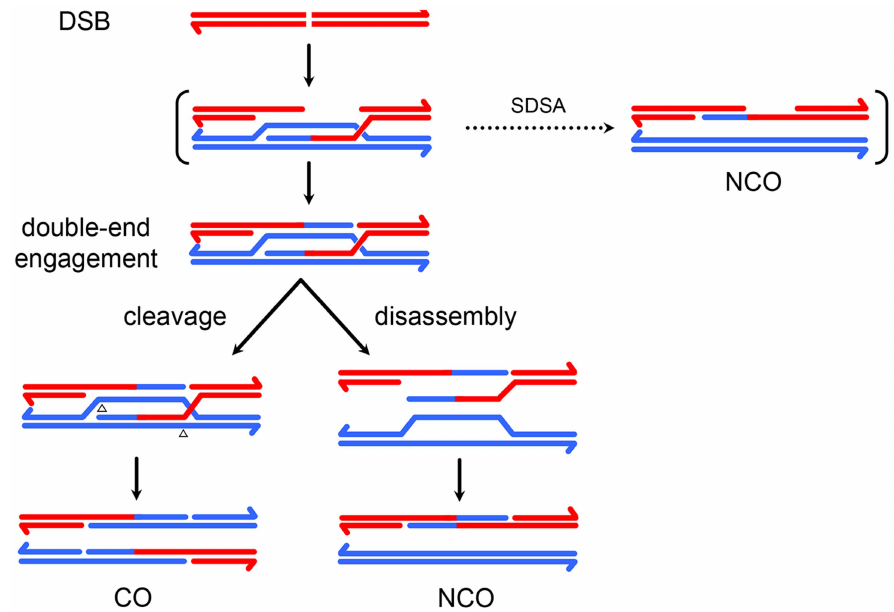
Figure 6. A model for meiotic recombination in Drosophila . At the top is a chromatid with a DSB, which enters into recombination with a chromatid on the homologous chromosome. A single-end invasion intermediate may be transient (indicated by brackets) or may give rise to some NCOs. Second-end capture and synthesis produces the two-end engagement intermediate. COs arise by nicking of this intermediate across from the existing nicks (arrowheads). NCOs arise by disassembly of the two-ended engagement intermediate by a helicase. In the version drawn here, resection is symmetric with respect to the DSB and synthesis tracts are the same length as resection tracts, resulting in nicked HJs. It is possible that resection and/or strand invasion/strand capture are asymmetric. It is also possible that synthesis does not extend all the way across the resected region, leaving a three-stranded junction instead of a nicked HJ. These possibilities, while compatible with the data, do not change the major features of the model.